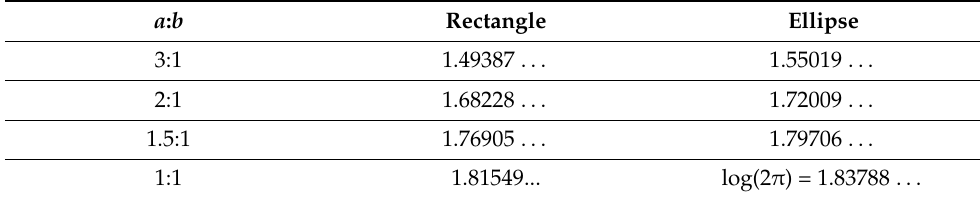
Table 2. The shape entropies of rectangles and ellipses.